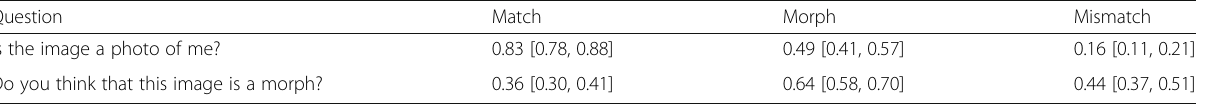
Table 2 A summary of the data for Experiment 3. These values represent the mean proportion of “ yes ” responses received by models for each condition Question Match Morph